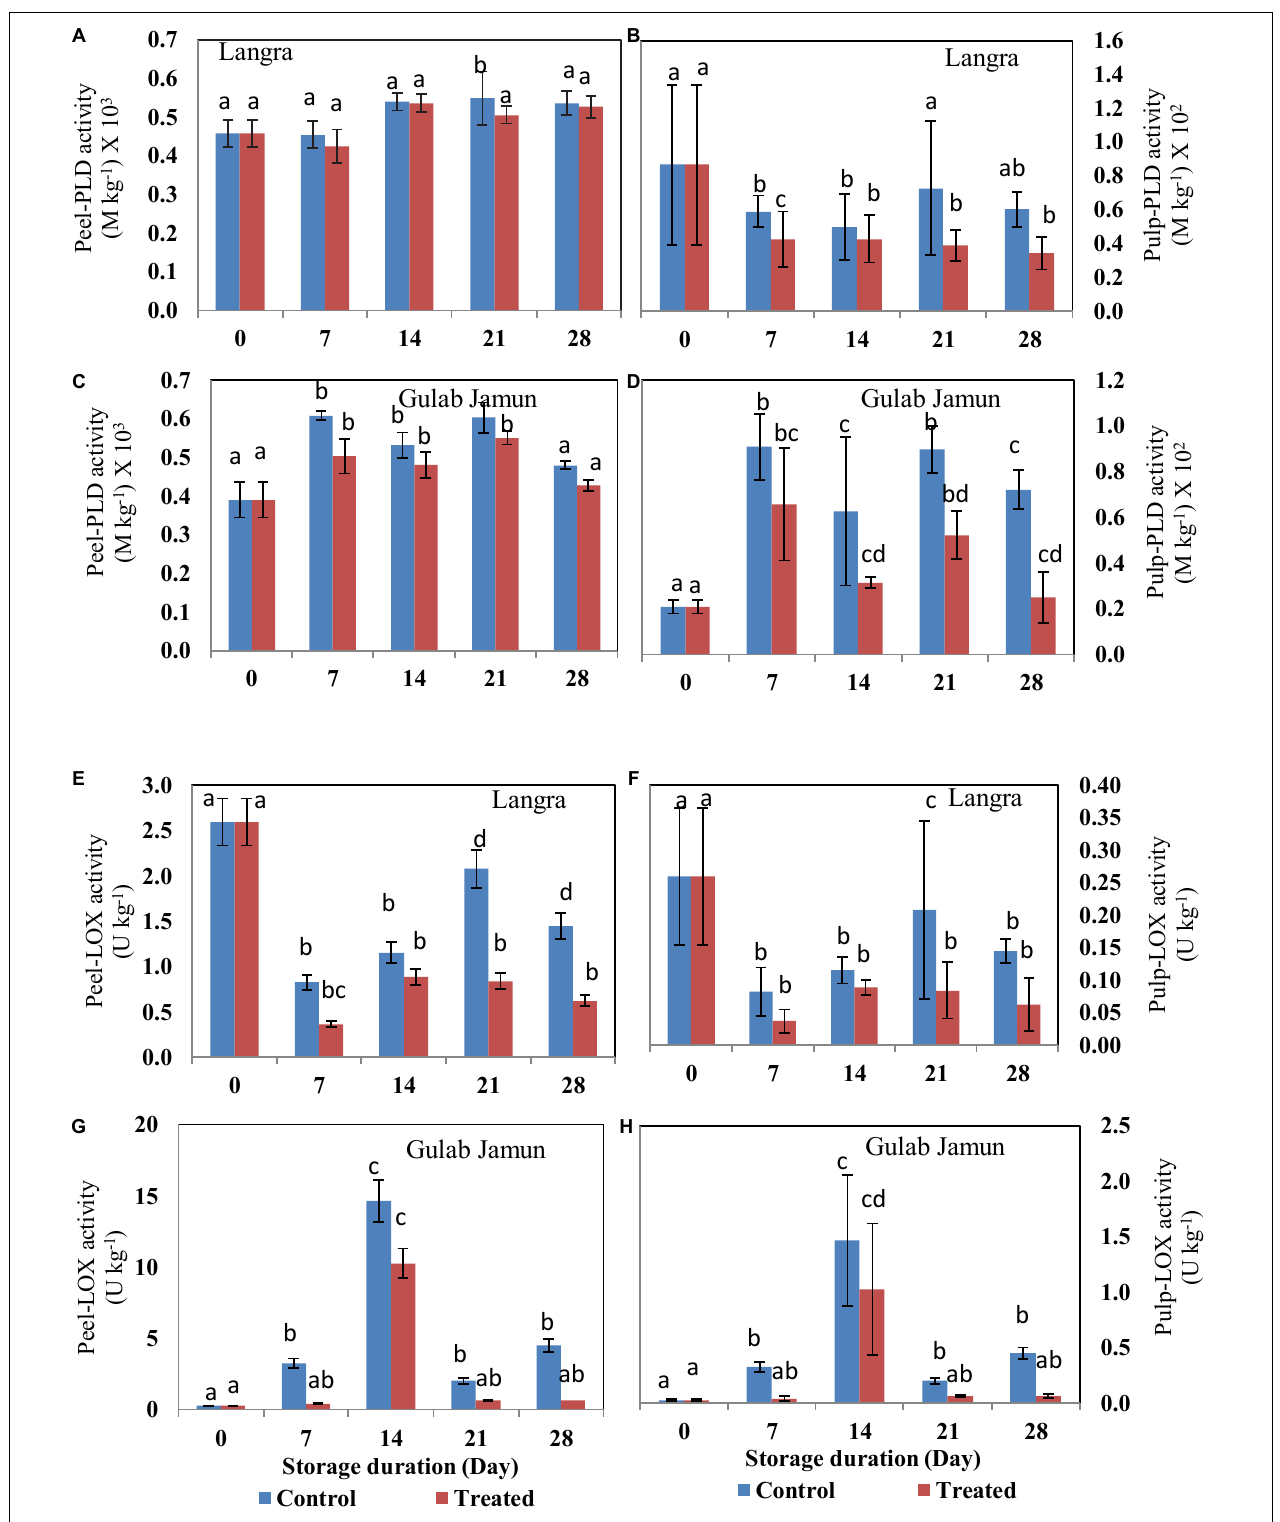
FIGURE 4 | Phospholipase D (PLD) activity in (A) ‘Langra’ peel, (B) ‘Langra’ pulp, (C) ‘Gulab Jamun’ peel, and (D) ‘Gulab Jamun’ pulp and lipoxygenase (LOX) activity in (E) ‘Langra’ peel, (F) ‘Langra’ pulp, (G) ‘Gulab Jamun’ peel, and (H) ‘Gulab Jamun’ pulp treated with 0 µ M (control) or 100 µ M (treated) MT for 2 h, followed by 28 days of storage at 5 ± 1 ◦ C and 3 days of shelf life at room temperature (25 ◦ C, 90–95% RH). Measurements were taken on every 7 days of storage. Each value is the mean of three replicates ± standard error. Error bars with different small letters on the same storage period show a significant difference ( P ≤ 0.05).